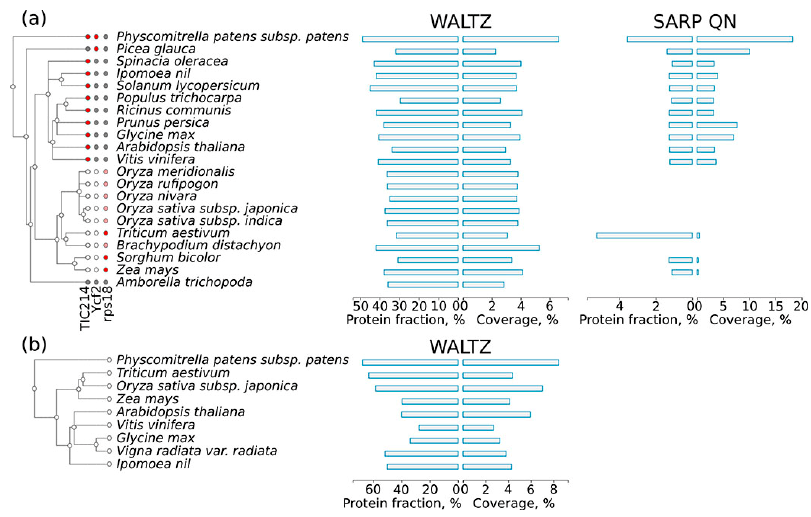
Figure 6. ( a ) Distribution of chloroplast sequences potentially capable of forming amyloids across land plant proteins. A taxonomic tree of plant species is shown according to the Uniprot Taxonomy. The results for amyloidogenic regions predicted by Waltz and QN-rich sequences found with SARP are shown. For each type of amyloidogenic region, the fraction of proteins harboring these regions and the coverage of the total proteome length with these regions are shown. For the TIC214, Ycf2 and rps18 proteins: (i) a red circle means that the protein is present in the proteome and has a QN-rich region; (ii) a gray circle denotes that the protein is encoded by the chloroplast genome but lacks a QN-rich region; (iii) a white circle denotes that there is no corresponding gene in the chloroplast genome; and (iv) a pink circle denotes that the rps18 protein has a small, manually verified QN-rich region. ( b ) Distribution of potentially amyloidogenic regions across higher plant proteins encoded by the mitochondrion genome. A taxonomic tree of plant species is shown according to the Uniprot Taxonomy. The results for Waltz-predicted regions are shown. For each type of amyloidogenic region, the fraction of proteins harboring these regions and the coverage of the total proteome length with these regions are shown. The results for QN-rich proteins predicted by SARP are not shown since such proteins are absent in the proteome of the